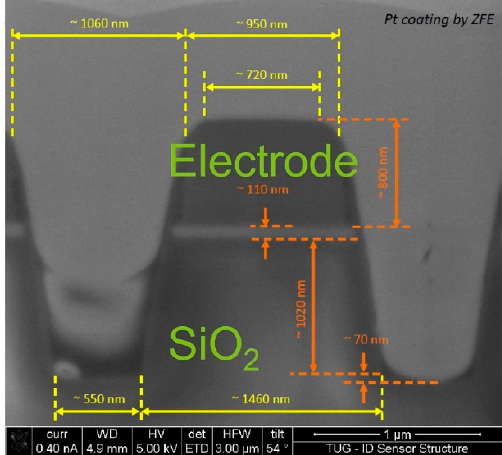
Figure 5. FIB cross-section of the sensor done at FELMI-ZFE. The shape of the electrodes is trapezoidal rather than rectangular. Also electrodes are slightly underetched due to a time-dependent etching step in the fabrication